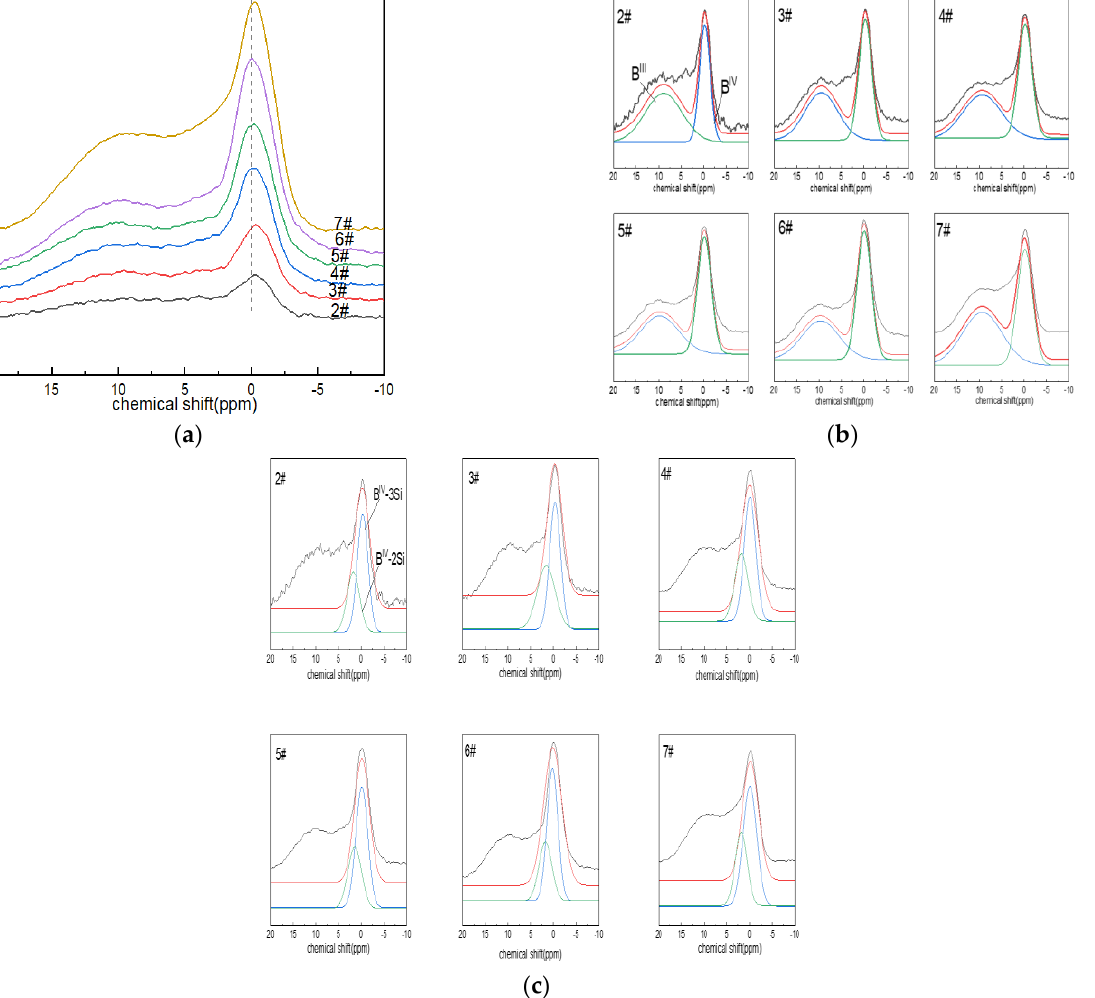
Figure 2. ( a ) 11 B MAS NMR images of Li 2 O − Al 2 O 3 − SiO 2 glass with different B 2 O 3 contents; ( b , c ) fit- ting diagram of 11 B MAS NMR peaks of Li 2 O − Al 2 O 3 − SiO 2 glass with different B 2 O 3 contents.